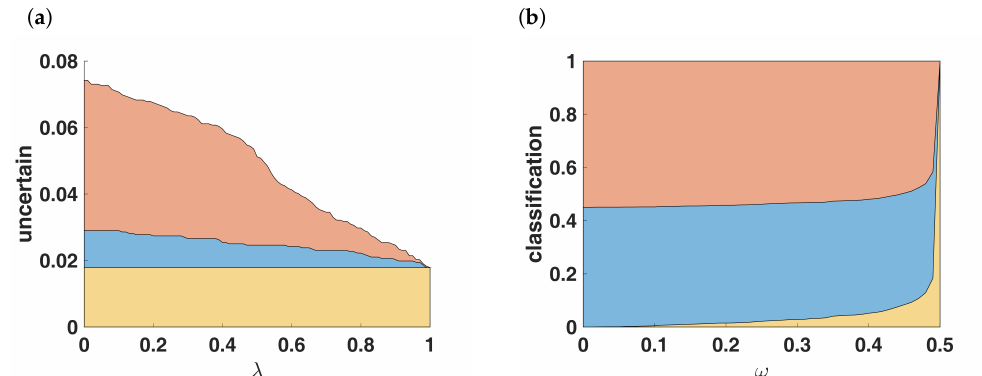
Figure 9. Uncertainty vs. flexible risk. ( a ) Increasing risk decreases uncertainty: The number of uncertain samples depends on the parameter λ in combining the hormone receptors with m esr ⊗ m pgr . The yellow area shows 45 out of 2519 samples (1.8%) which will always be uncertain, independent of the choice of λ . The red area changes from uncertain to receptor positive with increasing λ , the blue area changes into receptor negative. ( b ) fixed mass of ignorance: number of classifications by fixing the weight m ( Ω ) = ω as described by Formula